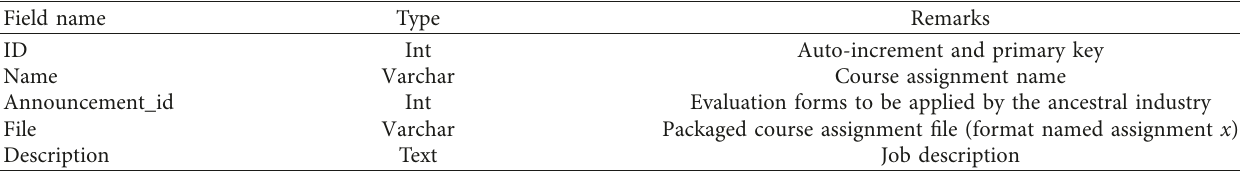
Table 9: Operation table.